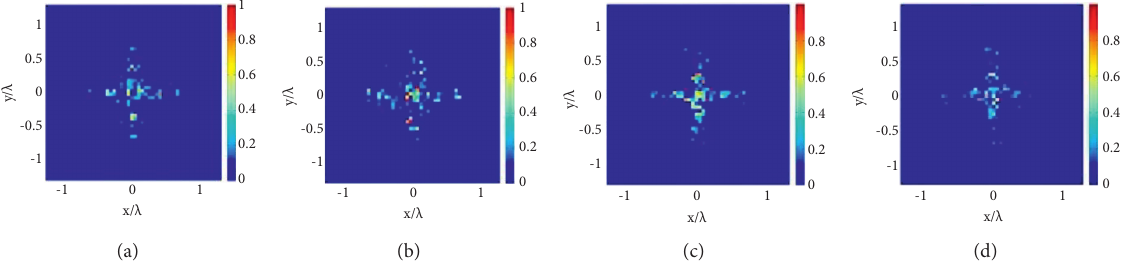
Figure 14: Sparse processing images (SHSP) of the cross-shaped PEC target in xOy plane. (a) θ -Oriented dipoles, SNR � 10 dB; (b)